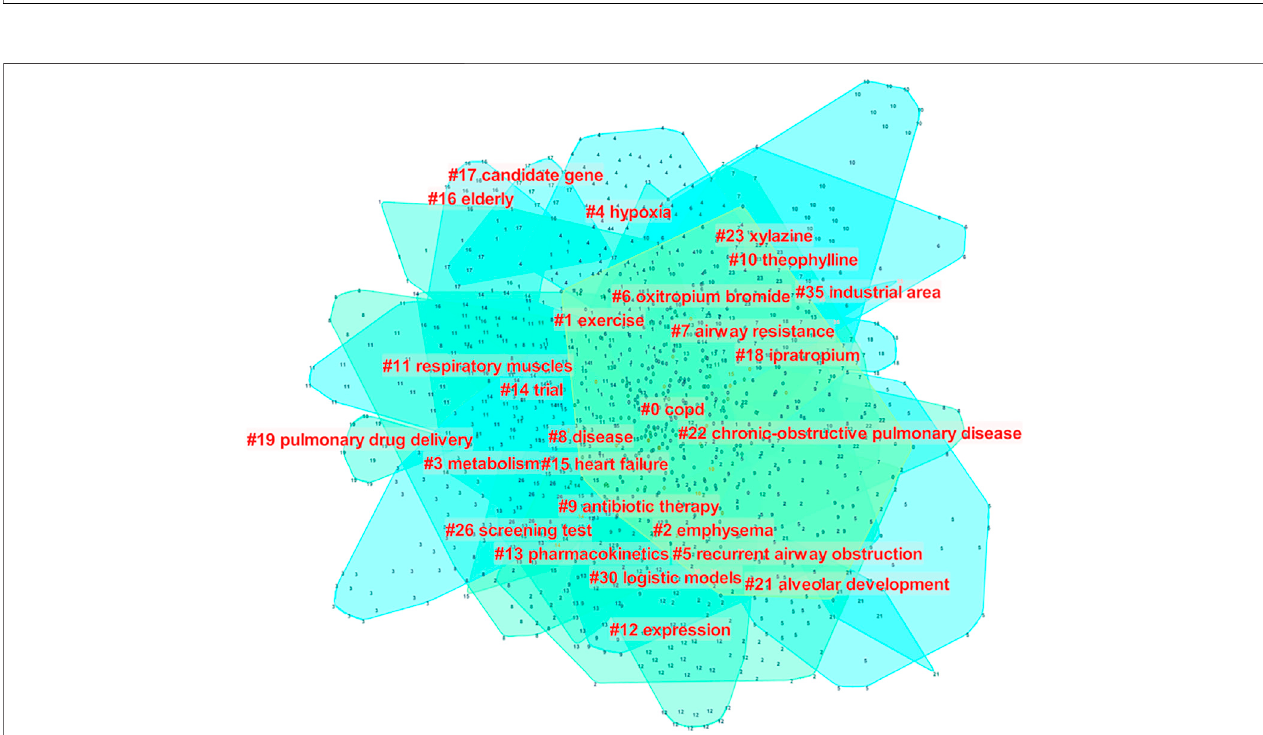
FIGURE 11 | Keywords co-occurrence analysis of COPD drugs-related studies that were published from 1980 to 2021.